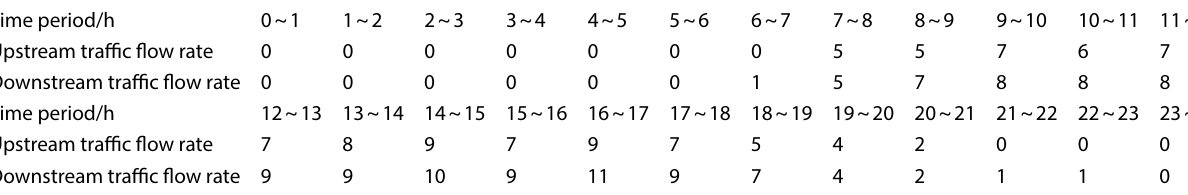
Table 2 Statistical mean of hourly ship traffic flow rate in a day (ves/h) Time period/h